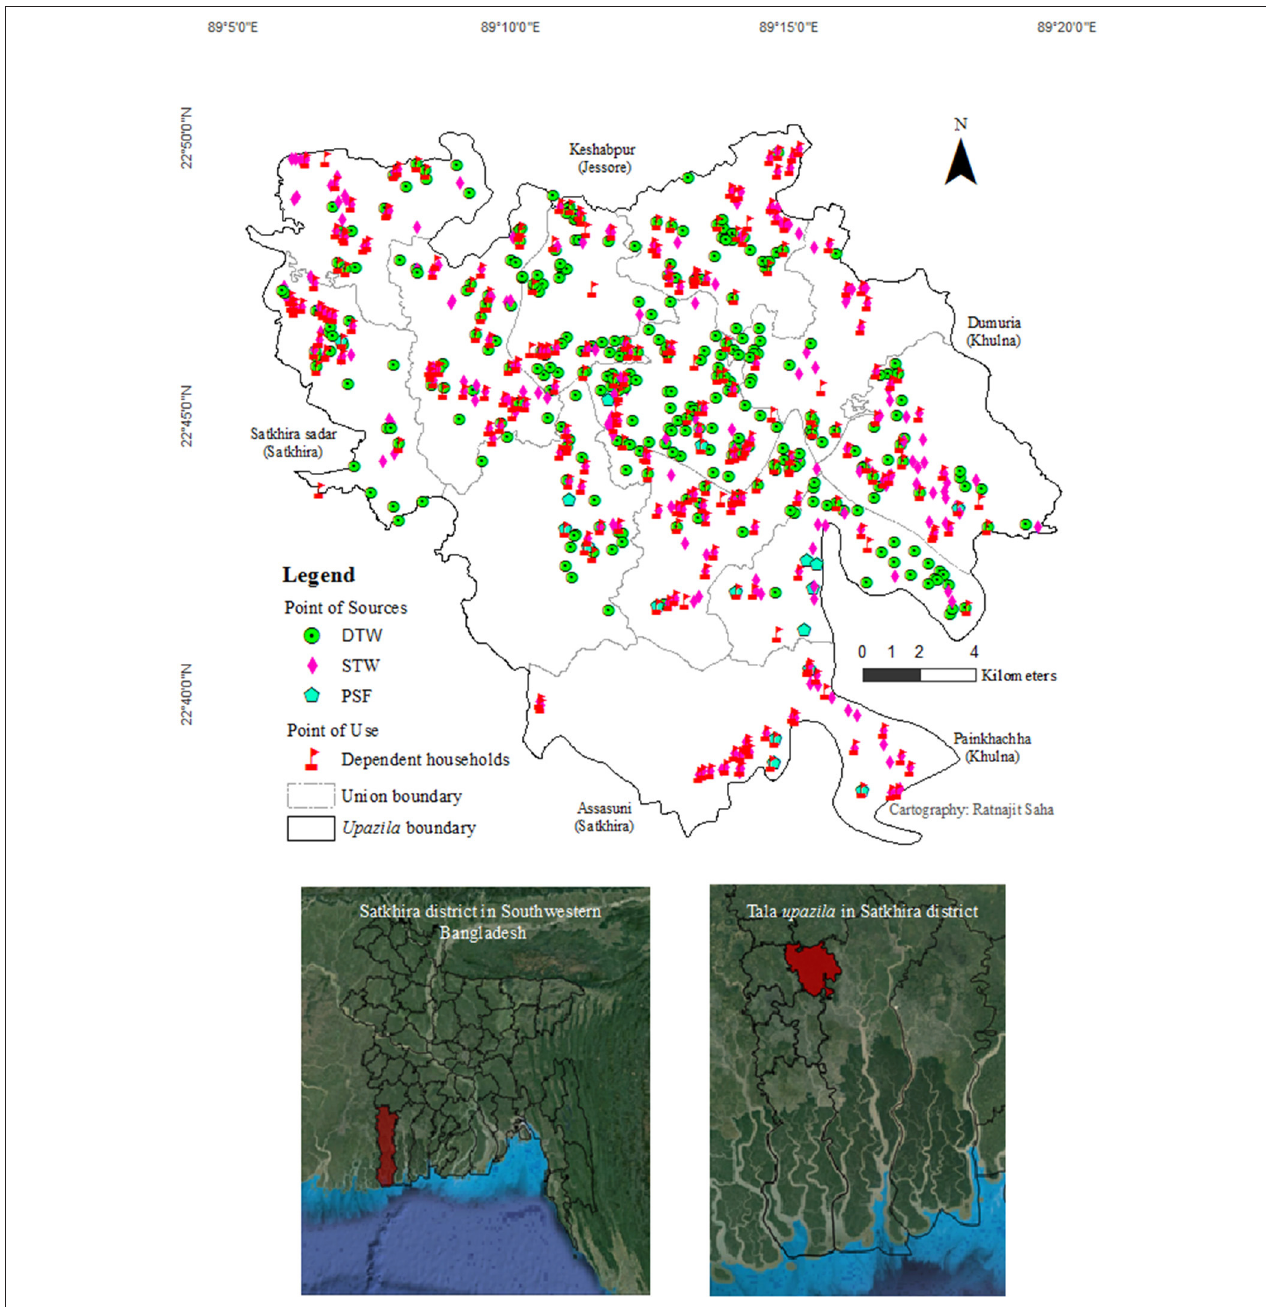
FIGURE 1 | Location of water sampling PoS and corresponding PoU in Tala upazila of Satkhira district in Southwestern